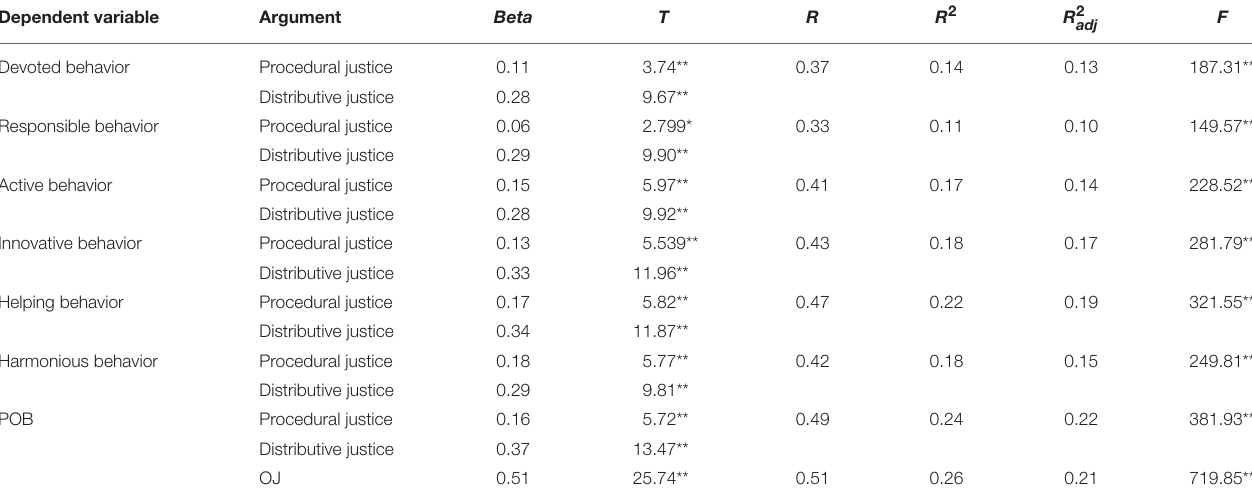
TABLE 2 | Regression analysis of OJ on POB ( n = 2566).